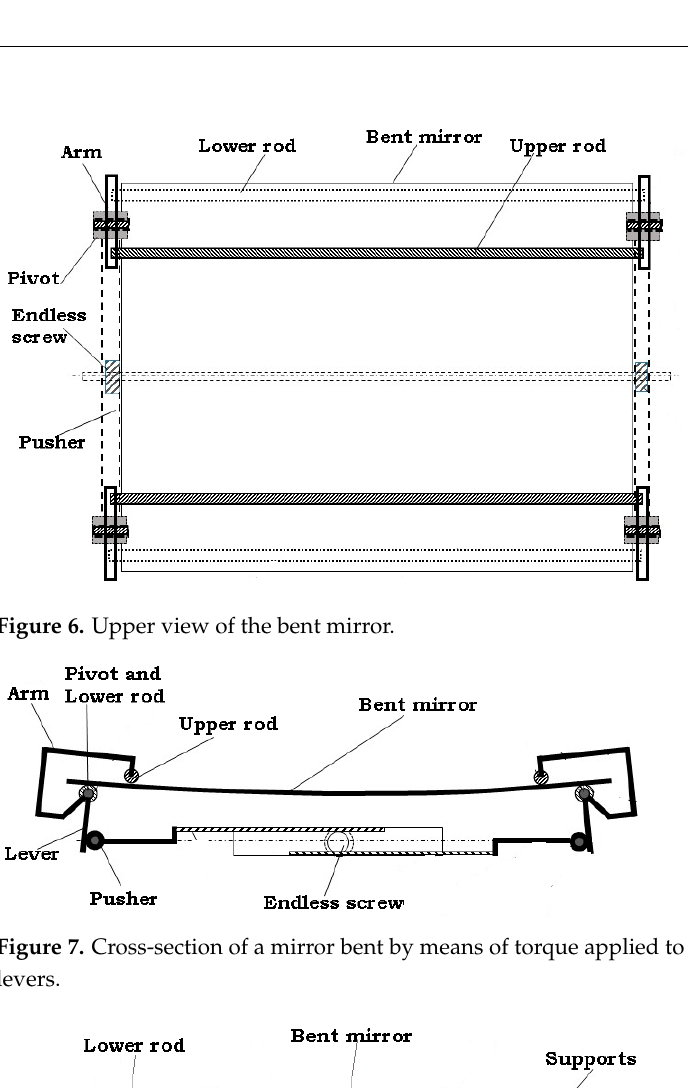
Figure 7. Cross-section of a mirror bent by means of torque applied to both lateral sides with lat- eral levers.